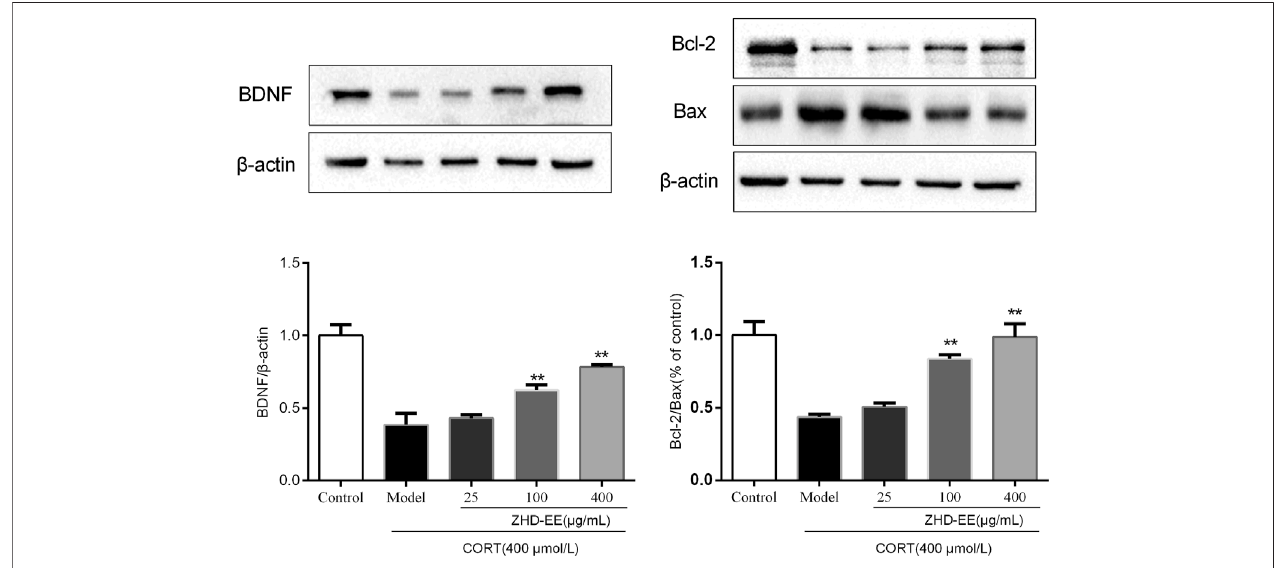
FIGURE 7 | Effects of ZHD-EE on the protein expression of BDNF, Bcl-2 and Bax in corticosterone-treated PC12 cells by western blot analysis. The data are presented as the mean ± SD ( n = 3). ## p < 0.01 compared with the control group, ** p < 0.01 compared with the CORT-treated group. ZHD-EE: ethanol extract of ZHD.